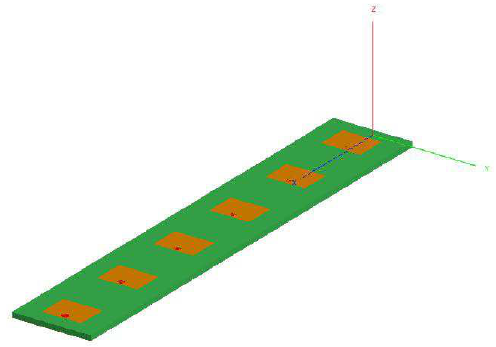
)—Sketch of the linear array of rectangular patches. 2